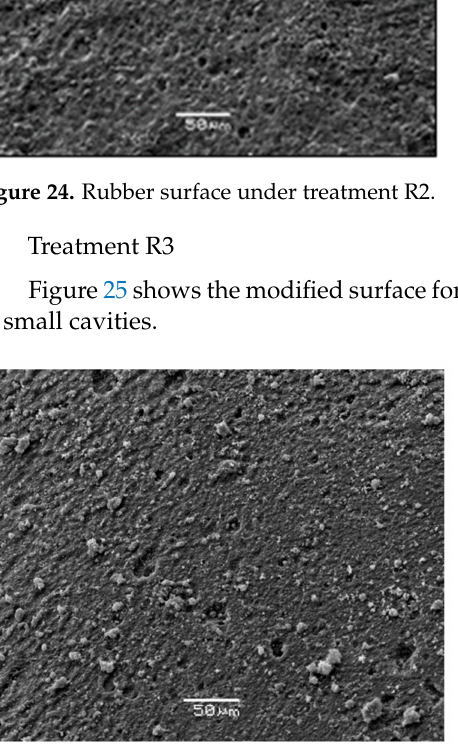
Figure 25. Rubber surface under treatment